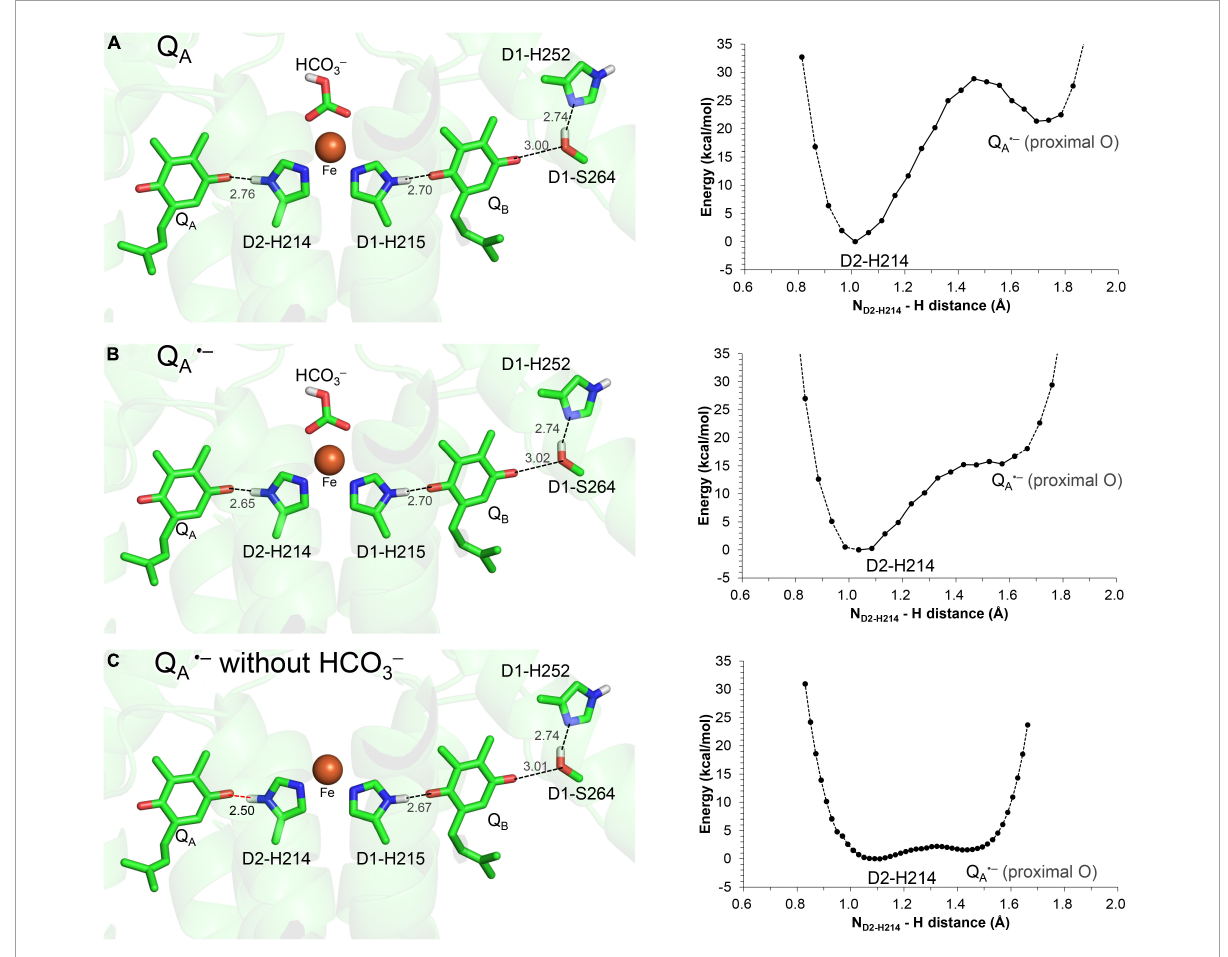
FIGURE2 QM/MM-optimized geometry and potential energy profile for the H-bond between Q A and D2-His214 prior to electron transfer from Q A to Q B . (A) Neutral Q A . (B) Q A ·− . (C) Q A ·− in the absence of the bicarbonate ligand. D1-Ser264 forms an H-bond with unprotonated D1-His252, as the electron is not transferred to Q B (Ishikita and Knapp, 2005a). Note that the geometry of each intermediate conformation is fully QM/MM